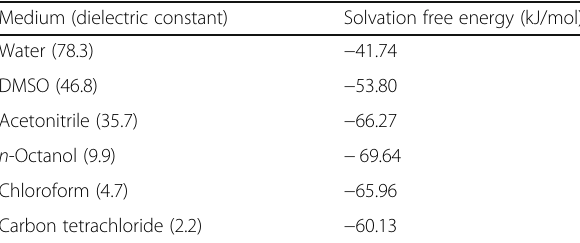
Table 2 Solvation free energy (kJ/mol) of betulinic acid in different solvents with SMD Medium (dielectric constant)